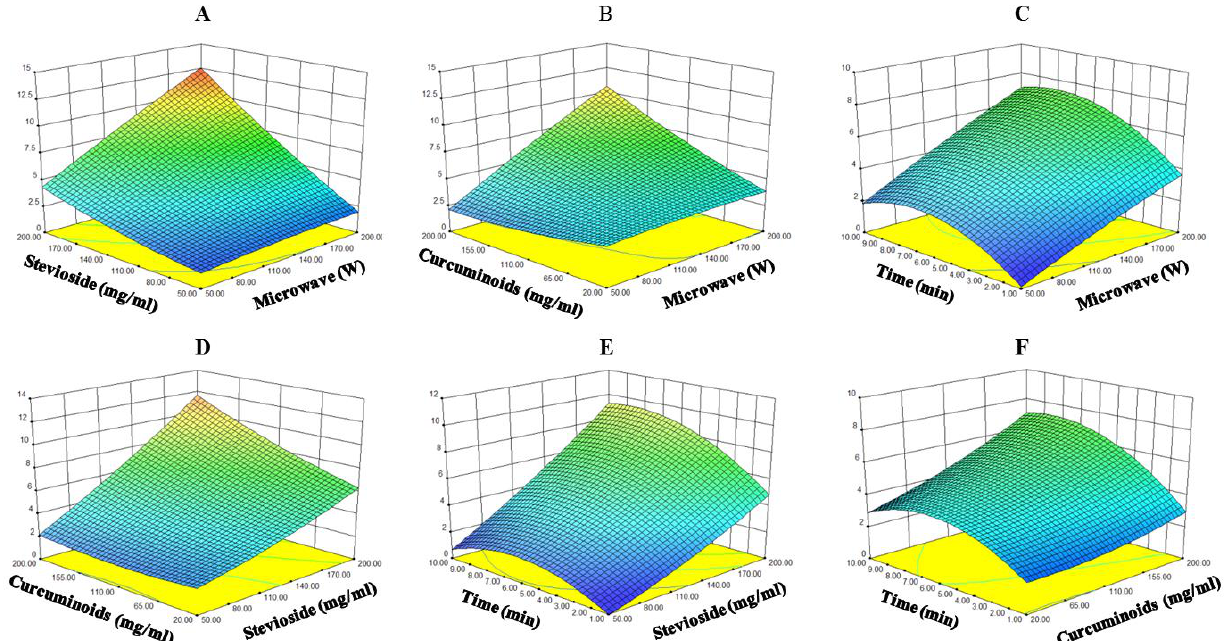
Figure 2. Response surface and contour plots of curcuminoid solubility with stevioside. Mutual interactions between stevioside concentration and microwave level ( A ), curcumin concentration and microwave level ( B ), time and microwave level ( C ), curcumin concentration and stevioside concentration level ( D ), time and stevioside concentration level ( E ), and time and stevioside concentration. Other parameter levels ( F ). All other parameters, except for the two in each figure, were at their respective zero